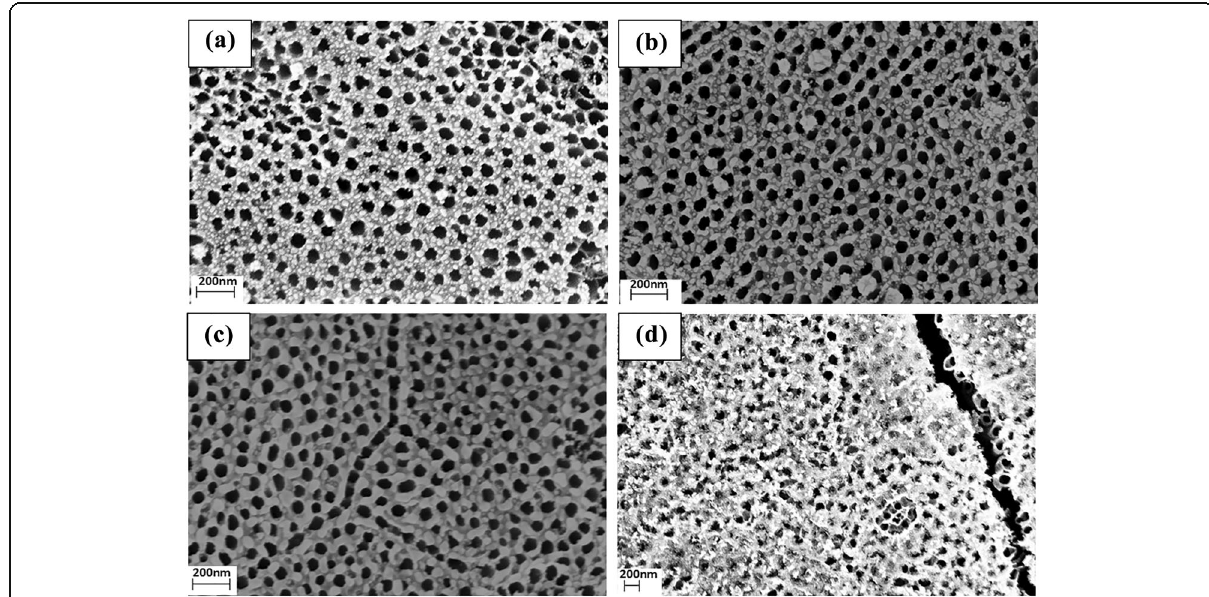
Fig. 3 SEM Images of Ag Nanoparticle-loaded TiO 2 Nanotube Arrays with sputtering durations of 30 s, 35 s, 40 s, and 45 s corresponding with ( a ) - ( d ),